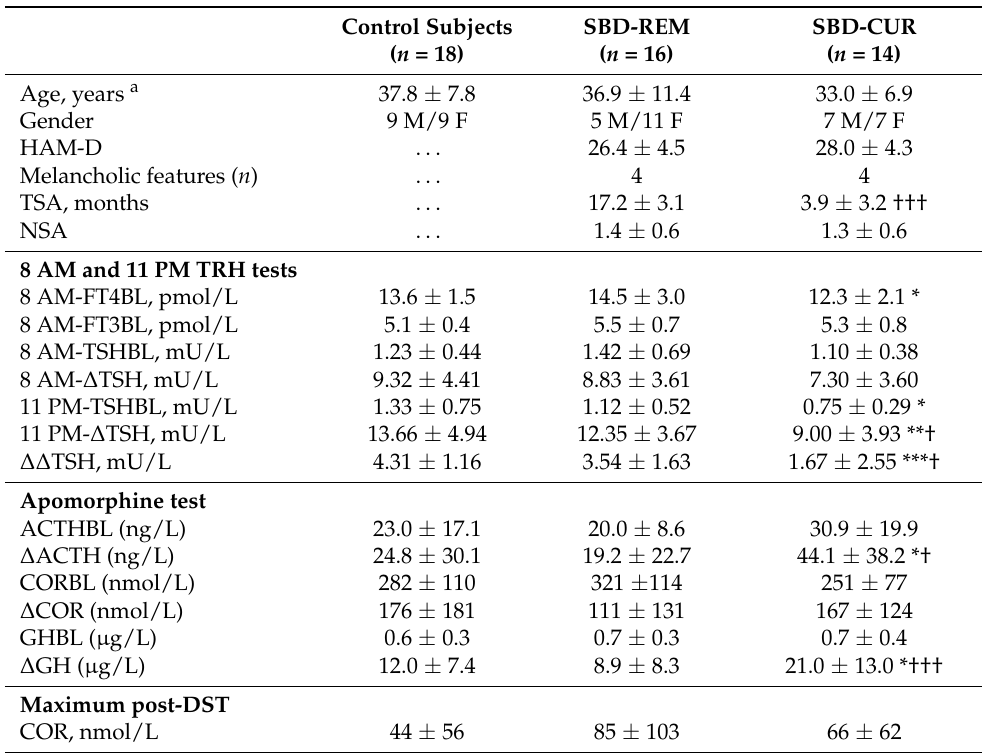
Table 1. Demographic characteristics and biological data for normal controls and depressed patients with DSM-5 suicidal behavior disorder classified according to specifiers: current or in early